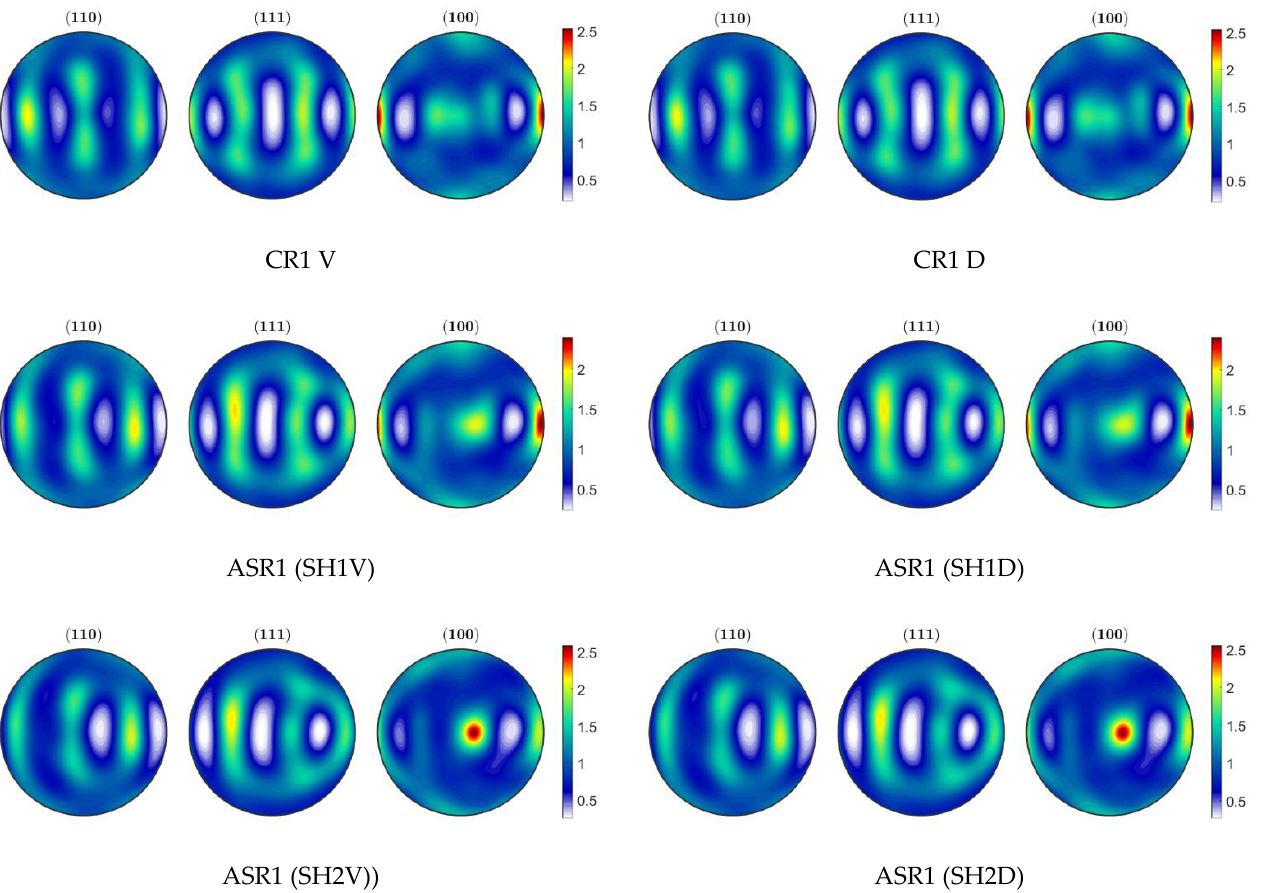
Figure A1. ODF sections for the first pass with a 20% thickness reduction per pass.